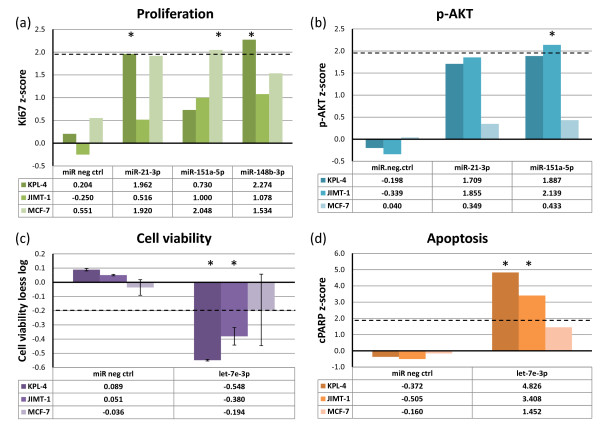
In-cis miRNAs show functional effects when overexpressed. Breast cancer cell lines were transfected with miRNA mimics (20 nM) and assayed for (a) cell proliferation (Ki67), (b) phosphorylated AKT (p-AKT) levels, (c) cell viability and (d) apoptosis (cleaved PARP (cPARP)), 72 hours after transfection. The dashed lines indicate cut-off points that were considered significant (see Materials and methods). Asterisks denote significant effects. The data for cell viability are from two replicate experiments with error bars showing standard deviations.